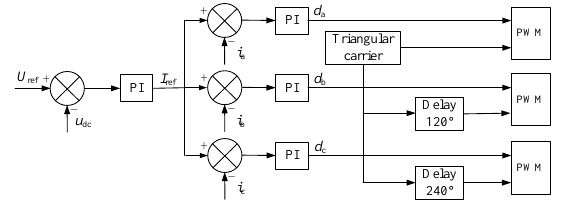
Figure 3. The dual-loop constant voltage PI control for the TIDC.